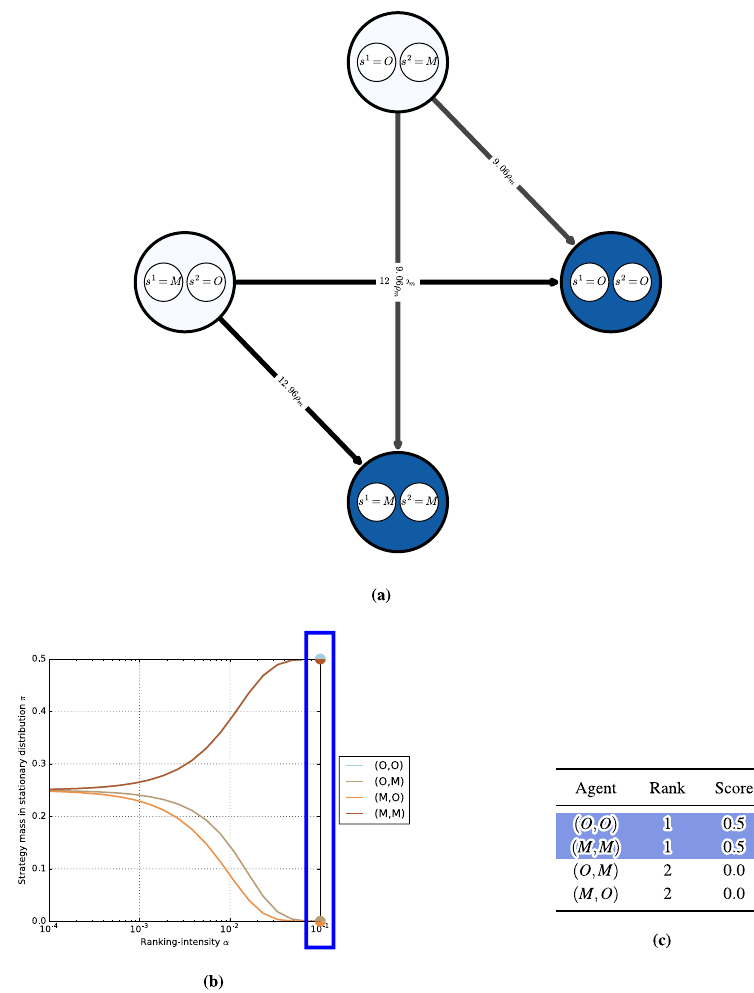
Figure 8. Battle of the Sexes. ( a ) Discrete-time dynamics (see ( c ) for node-wise scores corresponding to stationary distribution masses). ( b ) Ranking-intensity sweep. ( c ) α -Rank